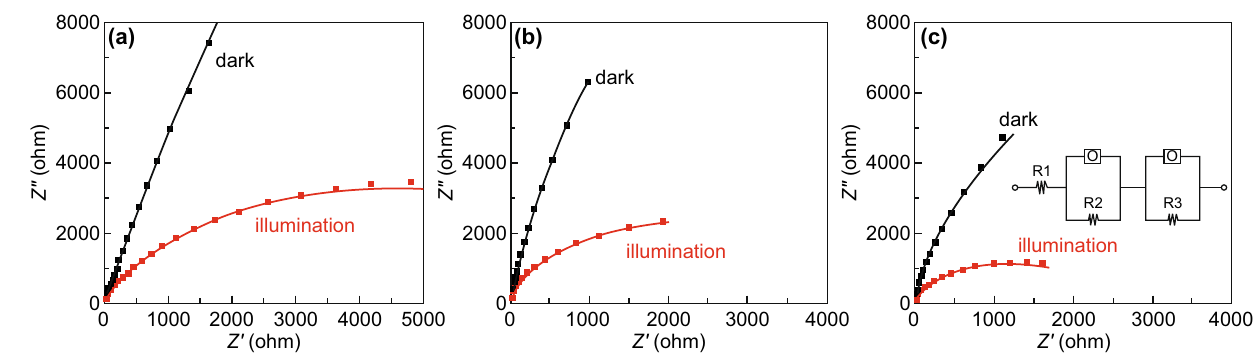
Fig. 8 Nyquist plots of a g-C 3 N 4 /TiO 2 , b TNTAs, and c g-C 3 N 4 /TNTAs electrodes in dark and with light irradiation